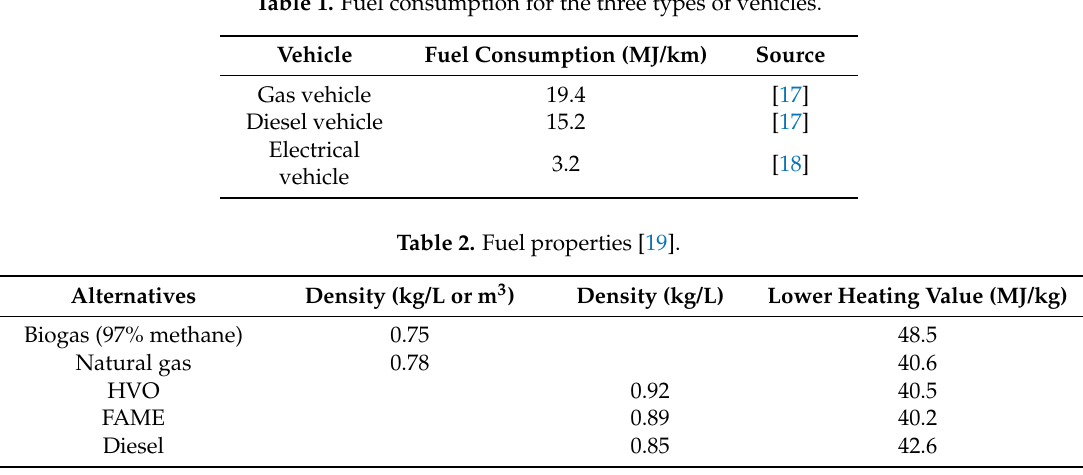
Table 1. Fuel consumption for the three types of vehicles.